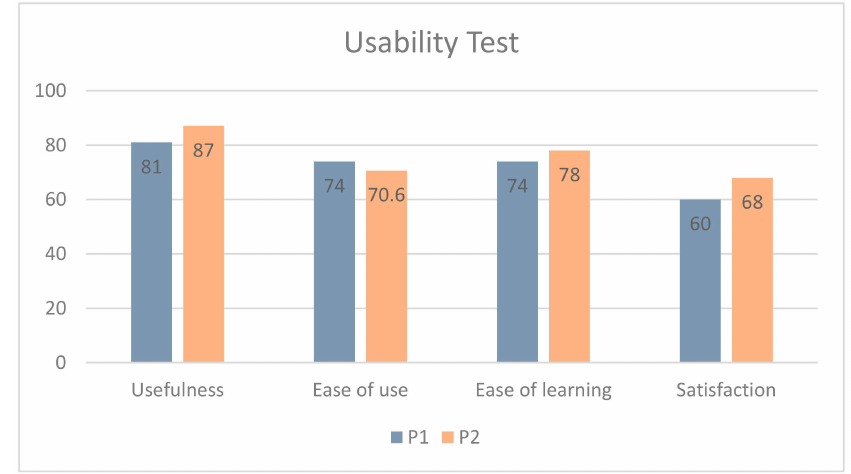
Figure 10. Results of usability